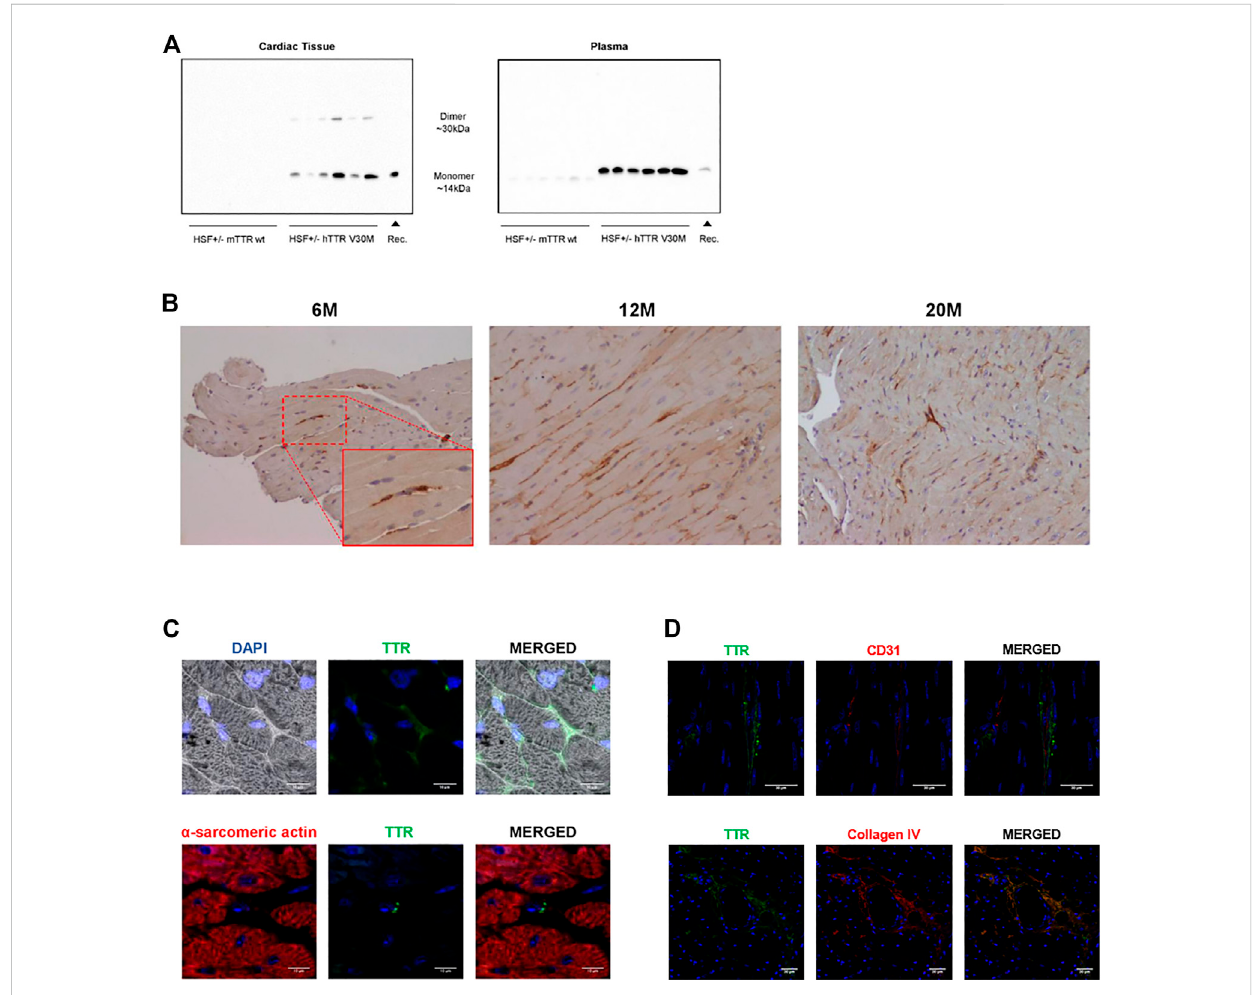
FIGURE 1 (A) TTR detection in cardiac homogenates and plasma samples. Immunoblot analysis of TTR levels in the cardiac tissue and plasma samples of HSF ± mTTR wt ( n = 6) and HSF ± hTTR V30M ( n = 6). TTR monomer was detected in both tissue and plasma samples whereas the dimeric form of this protein only appeared in tissue. (B) TTR deposition pattern in the cardiac tissue. Immunohistochemistry staining TTR in paraf fi n-embedded cardiac sections from HSF ± hTTR V30M mice at 6, 12, and 20 months. Magni fi cation 20x . (C) TTR subcellular localization in the cardiac tissue. Confocal microscopy of paraf fi n-embedded heart sections of HSF ± hTTR V30M mice. In the upper row a differential interference contrast (DIC) channel was addedtofacilitatevisualizationoftissuestructure.Onthelowerrow,alpha-sarcomericactinforcardiomyocytestainingappearsred.TTRisstainedgreen and nuclei are stained blue with DAPI. Scale bars, 10 µm. (D) TTR detection outside blood vessels. Confocal microscopy of paraf fi n-embedded heart sections ofHSF ± hTTR V30M mice. (A) TTR staining ispresenton theoutside of blood vessels, here stained with CD31. (B) Imagedepicting a large blood vessel with TTR co-localizing with collagen IV in the basement membrane. Nuclei are stained blue with DAPI. Scale bars, 30